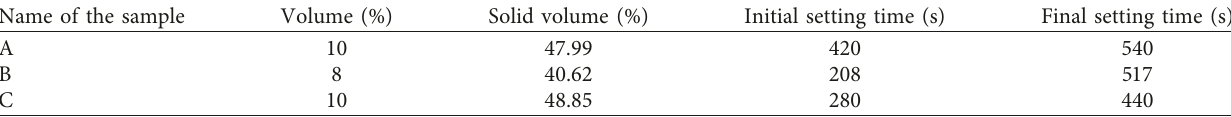
Table 2: Solid volume and setting time measurement results.